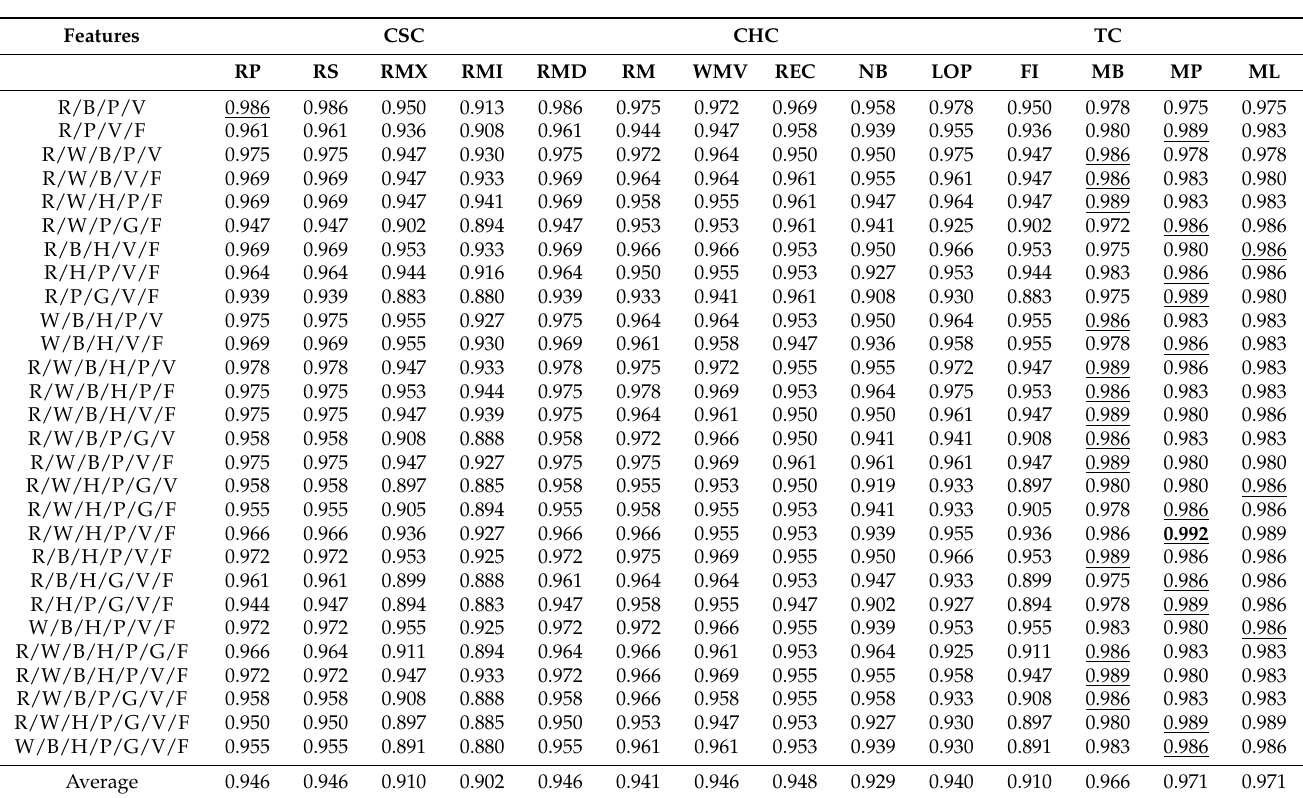
Table 3. Accuracy selection was greater than 0.985 for the 14-rule combination methods and 247 com- binations of eight subspaces in the CK+ data set. CSC: a combination of soft classifiers; CHC: a combination of hard classifiers; TC: trainable classifiers. Best classifier result is underlined. Best feature/classifier is in bold